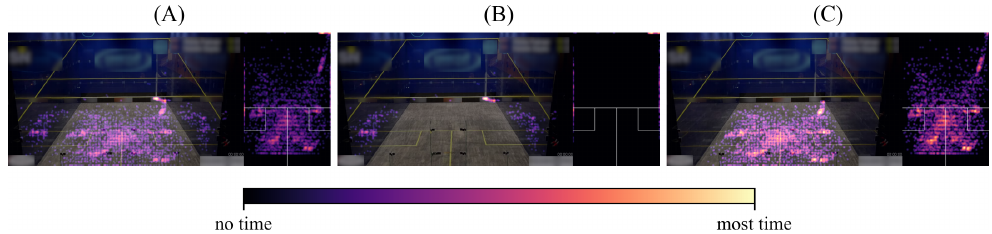
Figure 9. Domain-specific filtering enhances heatmap visualizations by excluding unwanted reflec- tions. In ( A ), the generated heatmap for A 1 F 0 and V 1 detections shows reflections and false detections outside the court’s boundaries. Filtering the unwanted detections shown in ( B ) results in a more convincing visualization, as shown in ( C